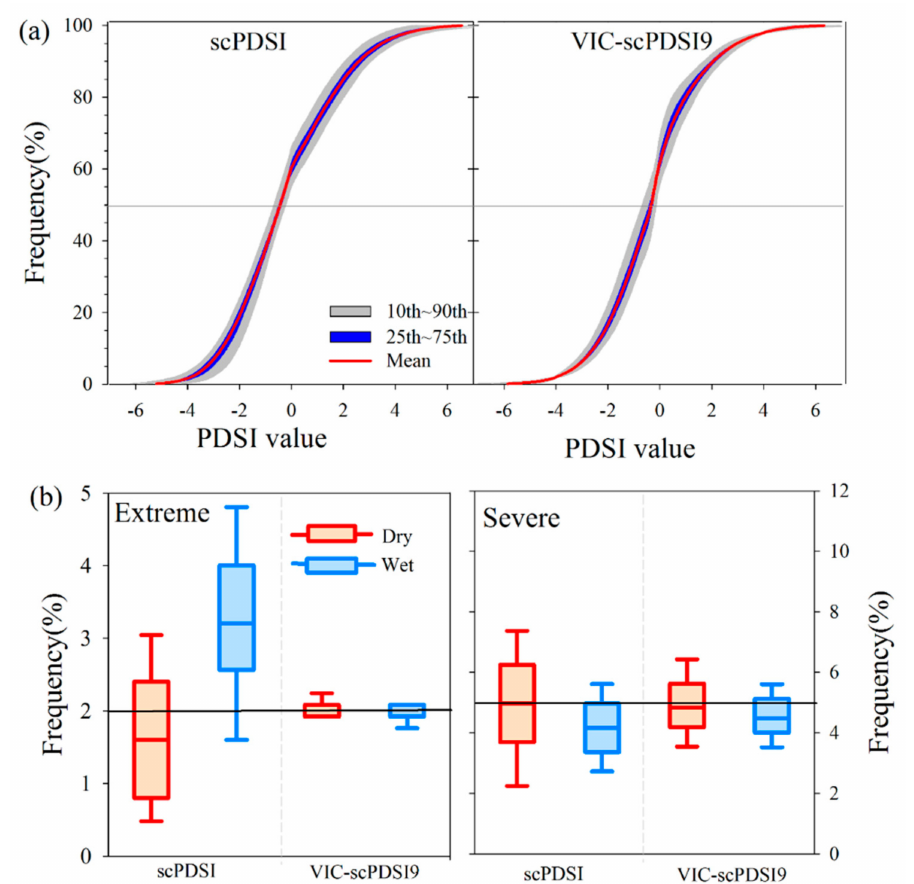
Figure 7. ( a ) Frequency distributions of scPDSI and VIC-scPDSI9 values. The grey and blue shadows denote the 75th–90th percentile range of frequency values over YRB. ( b ) The boxplots of scPDSI and VIC-scPDSI9 values of 1500 grids at extremely and severe dry